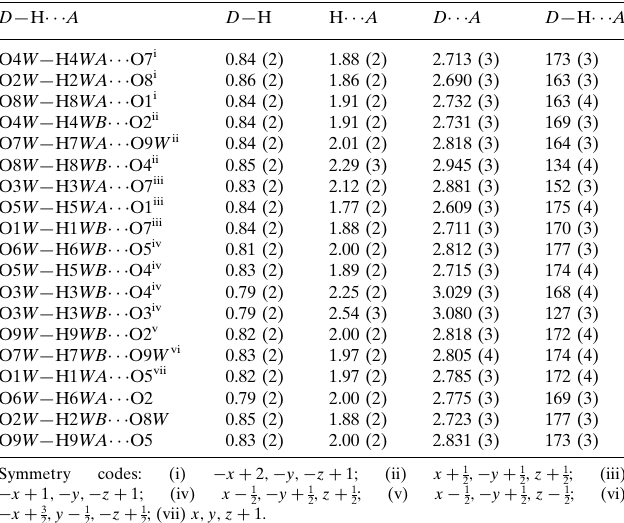
Hydrogen-bond geometry (A˚ , (cid:3)